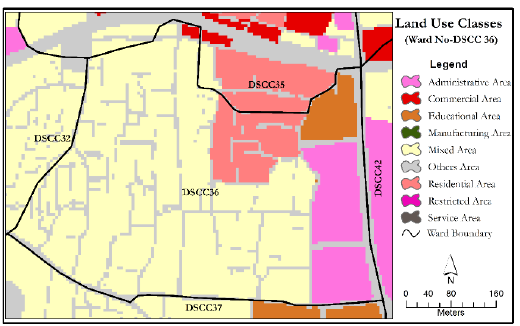
Figure 8. Output of the choropleth map of the study area.